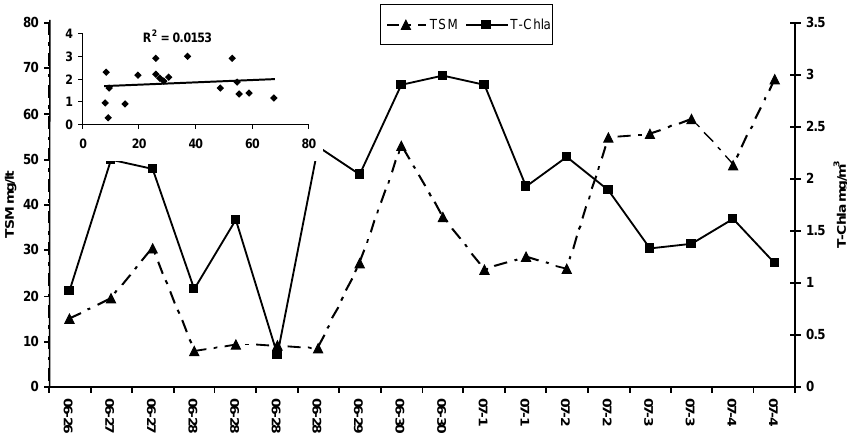
Fig. 7. Fluctuations of chlorophyll a and total suspended matter concentrations. The insert shows the relationship between suspended matter ( x axis, gm − 3 ) and chlorophyll ( y axis, mgm − 3 ).